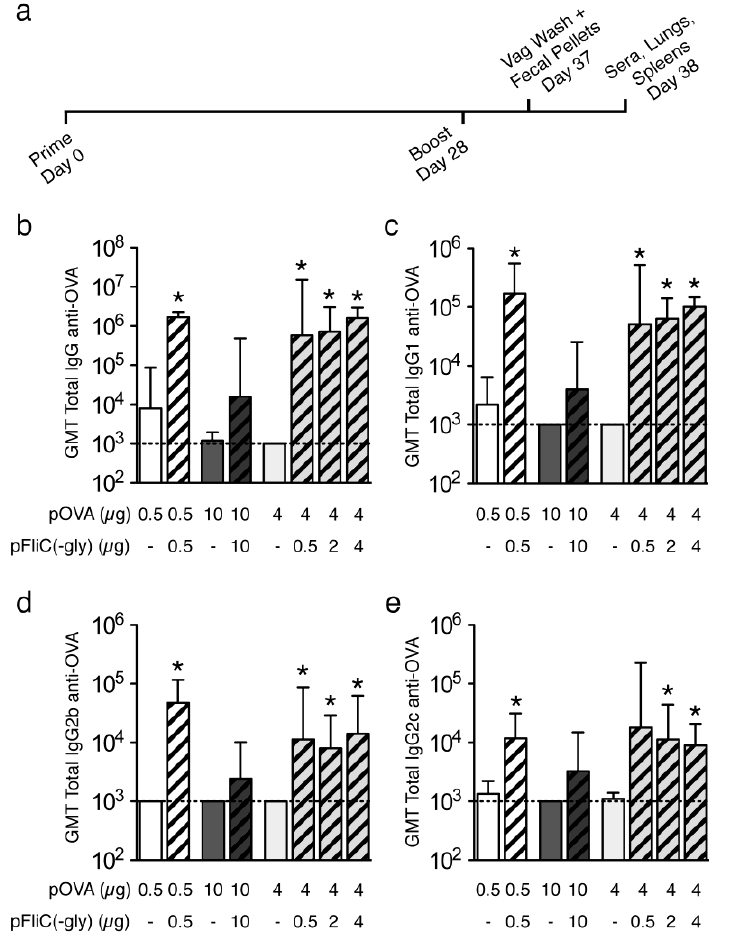
Figure 2. Vaccination schedule and serum antibody responses to OVA. ( a ) Immunization and sample isolation timeline; ( b ) Anti-OVA total IgG responses. Anti-OVA IgG1 ( c ), IgG2b ( d ), IgG2c ( e ) responses. (White bars) g.g. (Dark Grey Bars) i.m. (Grey bars) i.na. immunized mice. Striped bars indicate the use of pFliC(-gly). Results are representative